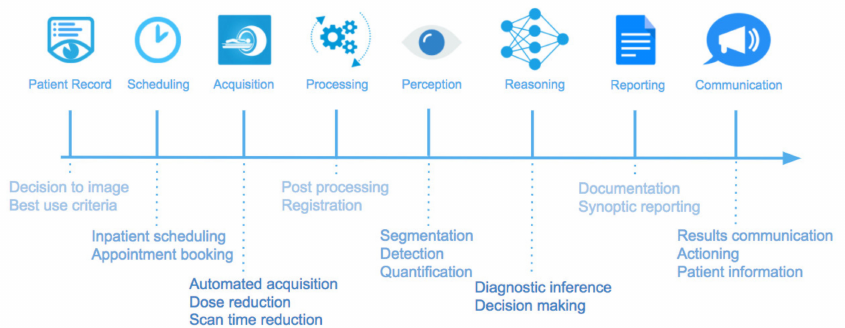
Figure 5. Stages within a radiology diagnostic workflow with potential artificial intelligence (AI) applications at each stage. This review focuses on the image analysis stage, incorporating image perception and reasoning. Image reproduced with permission from original author Dr. Hugh Harvey